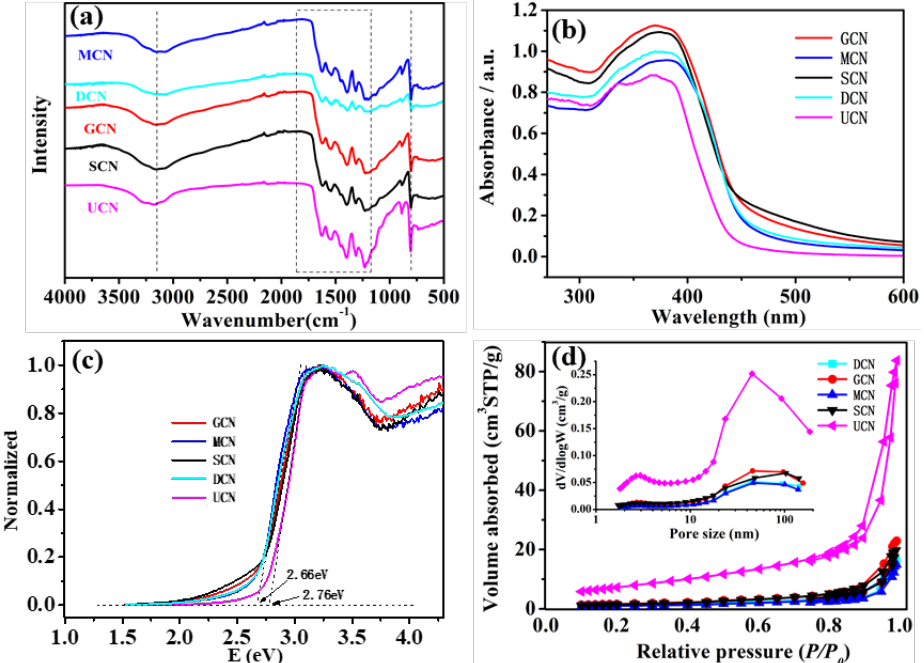
Figure 2. ( a ) FTIR and ( b ) UV-vis spectra of MCN, DCN, UCN, GCN and SCN samples. ( c ) Ku-belka- Munk curves from their UV-vis spectra. ( d ) Nitrogen adsorption-desorption curves on the MCN, DCN, GCN, SCN and UCN